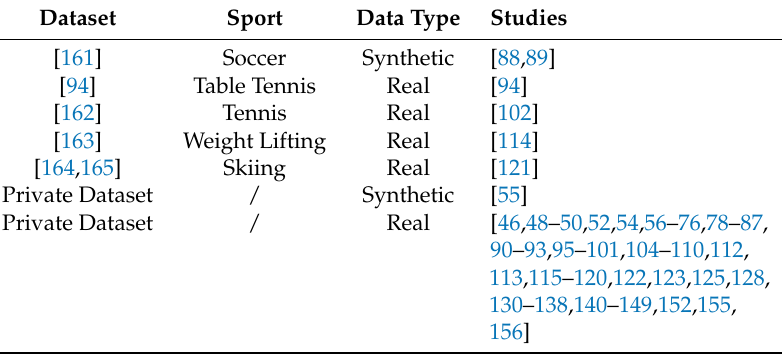
Table 22. Identified datasets and studies using